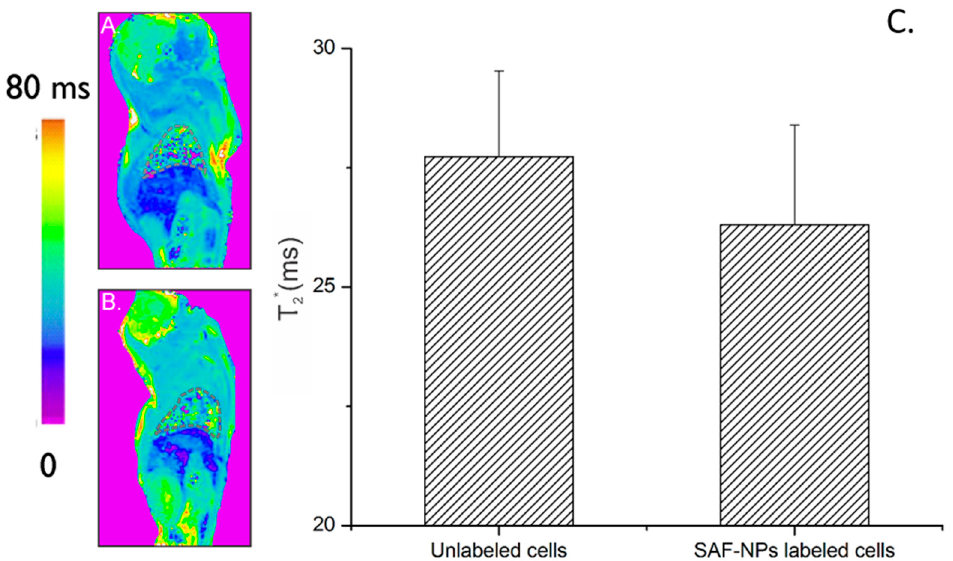
Figure 8. Parametric T2* maps (MRI) of mouse lungs after intravenous injection of 500,000 unlabeled ( A ) and SAF-NP-labeled ( B ) SKOV3 cells. ( C ) The dotted grey lines indicate the ROI of the lungs. No contrast was observed after injection of the SAF-NP-labeled cells, as shown in the graph where the T2* signal is plotted for both cases.